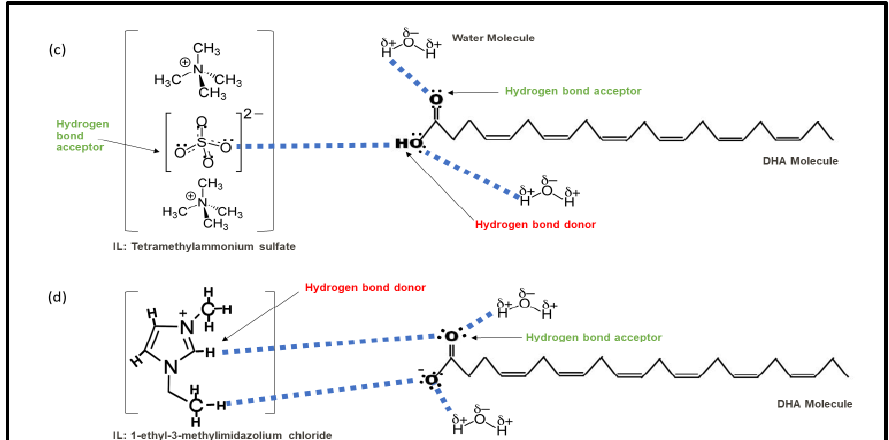
Figure 6. Proposed hydrogen bonding between the IL and DHA; ( a , b ) Suggested hydrogen bonding between the SO 42 − and DHA during extraction, ( c ): DHA and Tetramethyl ammonium sulfate, ( d ) DHA and 1-ethyl-3-methylimidazolium chloride, in aqueous-IL solution.